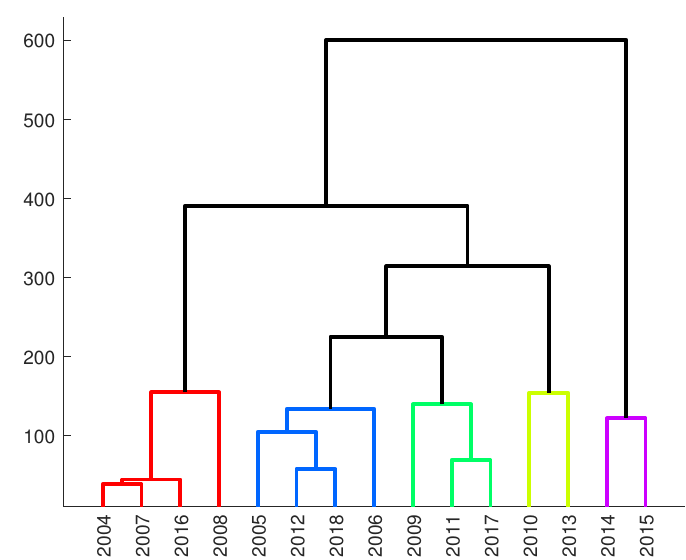
Figure 15. Dendrogram for time series of detrended groundwater levels corresponding to the summer seasons from applying the AHP clustering.